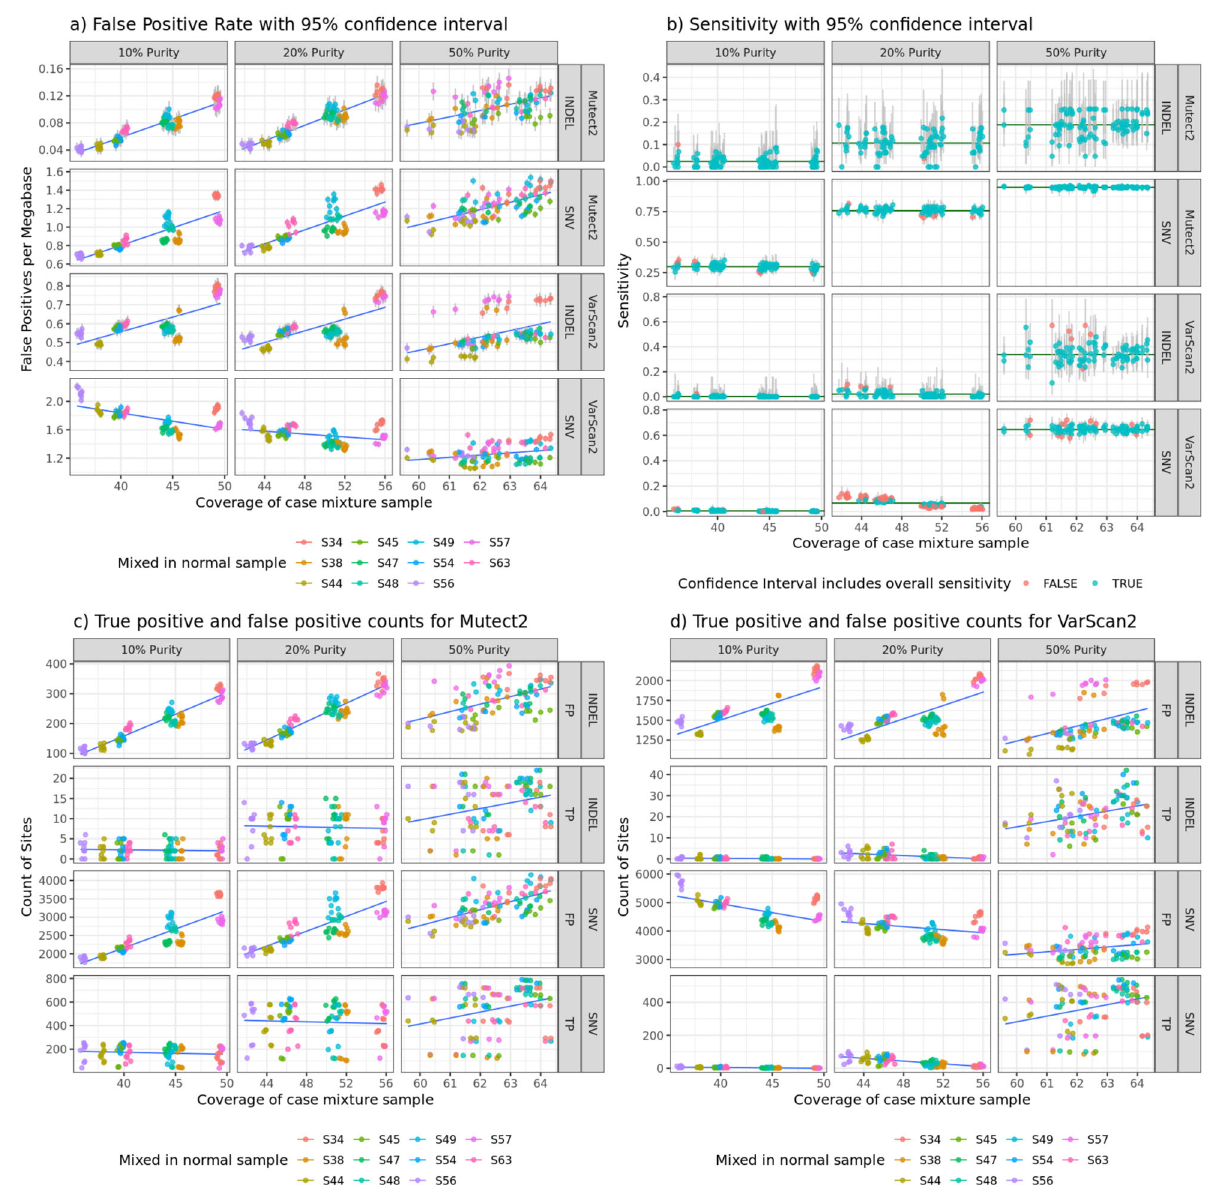
Fig. 2 False-positive rate, sensitivity, and counts of true-positive and false-positive calls from all possible mixtures run with Mutect2 and VarScan2. a False-positive rate clusters by the mixed-in normal sample at lower purities. This is owing to variability across samples in quality and false-positive rate. b Sensitivity mostly follows the expected model for each purity. Green horizontal line denotes overall sensitivity calculated across all mixtures. c Count of true positives and false positives called by Mutect2. d Count of true positives and false positives called by